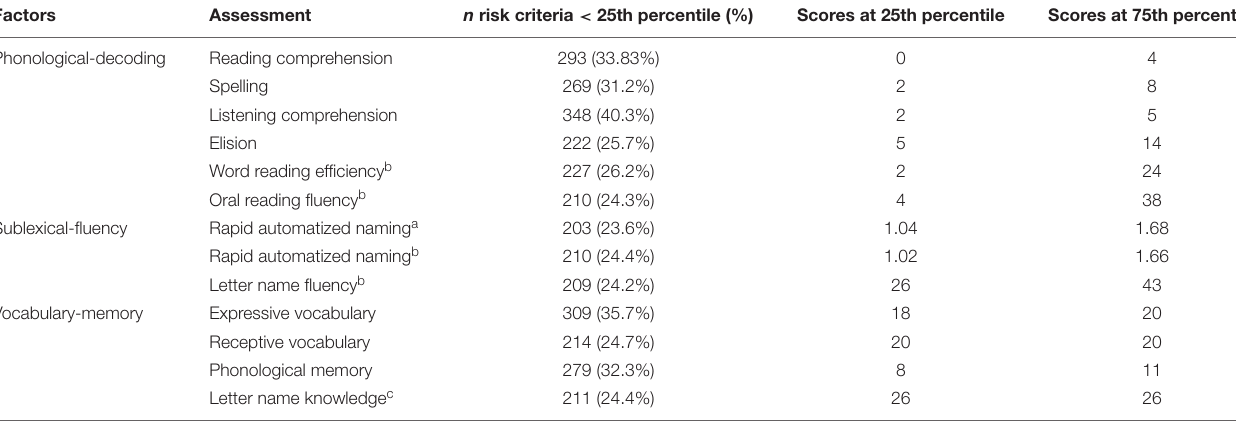
TABLE 5 | Distribution of the factors according to the cut-off at risk criterion below the 25th percentile.